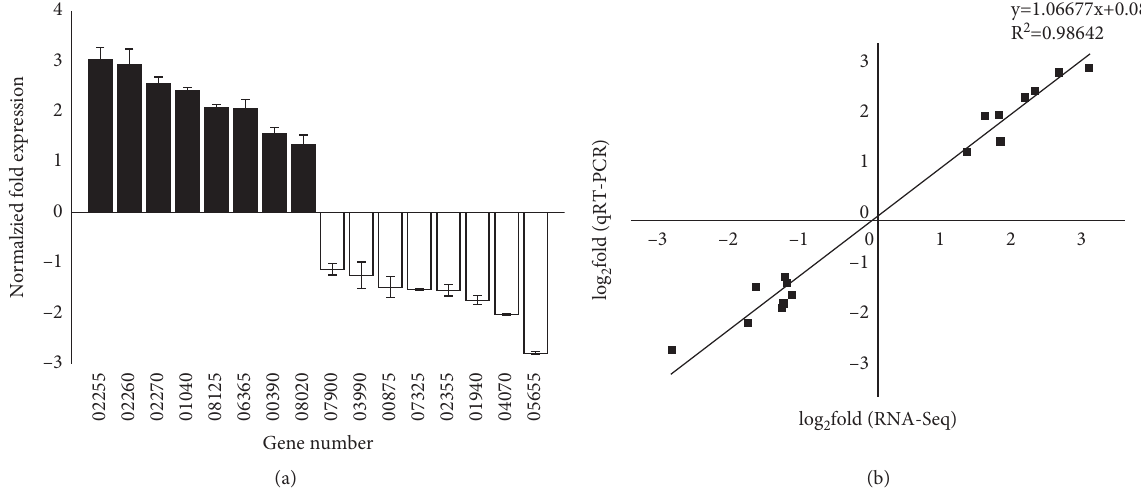
Figure 3: Results of expression profiles (a) and the linear fitting (b) of DEGs by qRT-PCR. Black column: upregulated; blank column: downregulated.